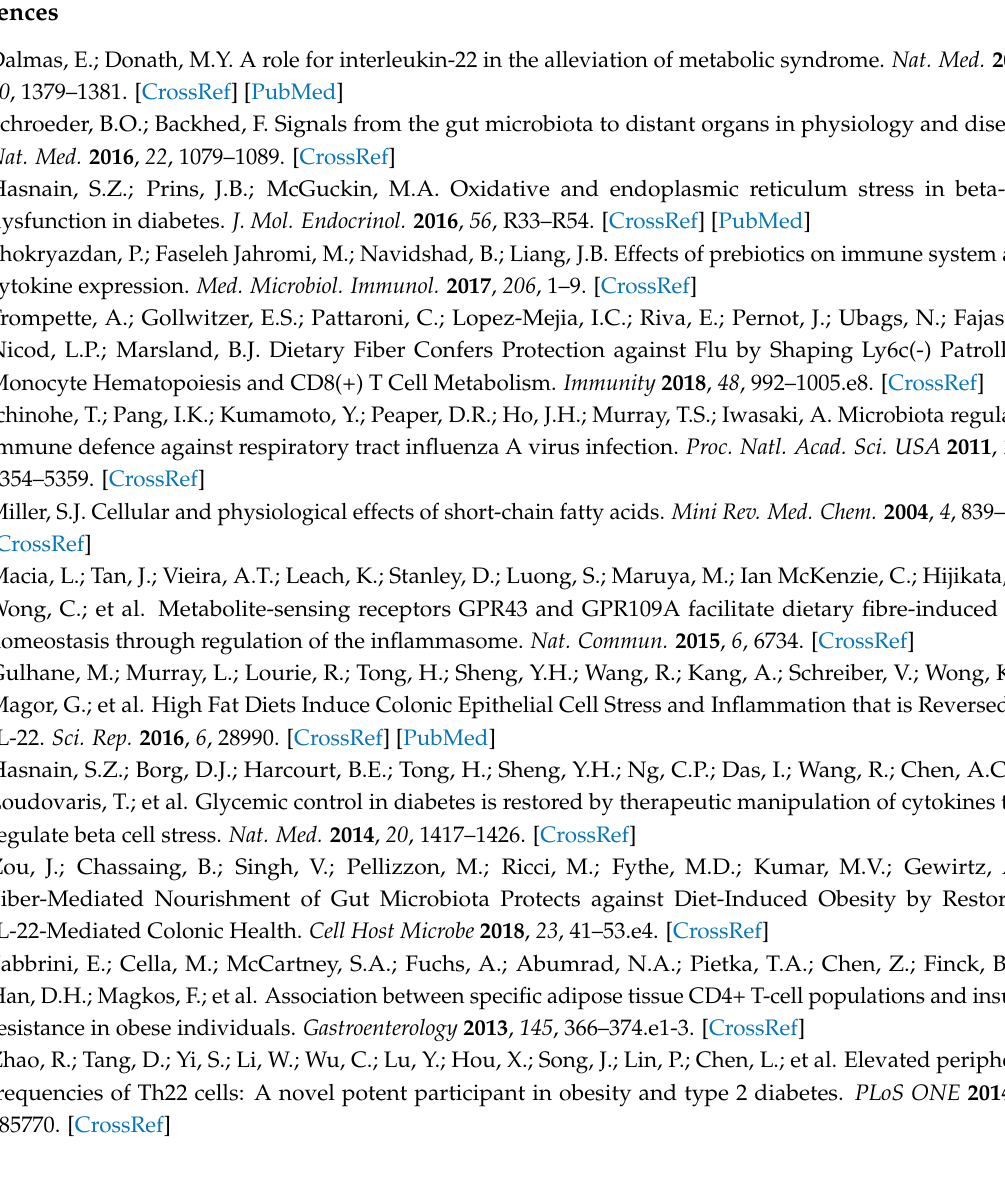
Figure S1: Bi-variate correlation between circulating IL-22 and Metabolic Syndrome z -score, Table S1: Comparisons between low-fibre vs. high-fibre intake